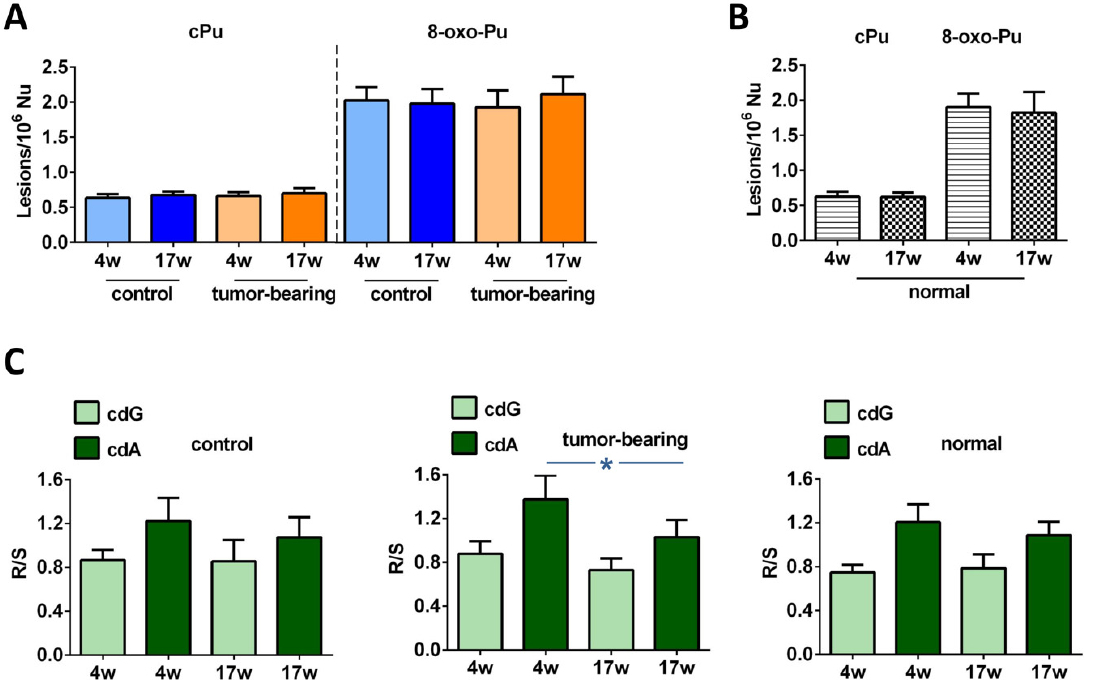
Figure 4. LC-MS/MS analysis of purine DNA lesions. ( A ) The levels (lesions/10 6 nucleosides) of cPu and 8-oxo-Pu in the brain tissue of control SCID and tumor-bearing SCID mice; for specific values see Tables S3 and S4. ( B ) The levels (lesions/10 6 nucleosides) of cPu and 8-oxo-Pu in the brain tissue of normal Swiss mice; for specific values see Tables S3 and S4. ( C ) The 5 ′ R /5 ′ S ratio of cdG and cdA in control SCID, tumor-bearing SCID, and normal Swiss mice; for specific values see Tables S5 and S6. The values are given as mean ± SD ( n = 6); * ( p < 0.05).